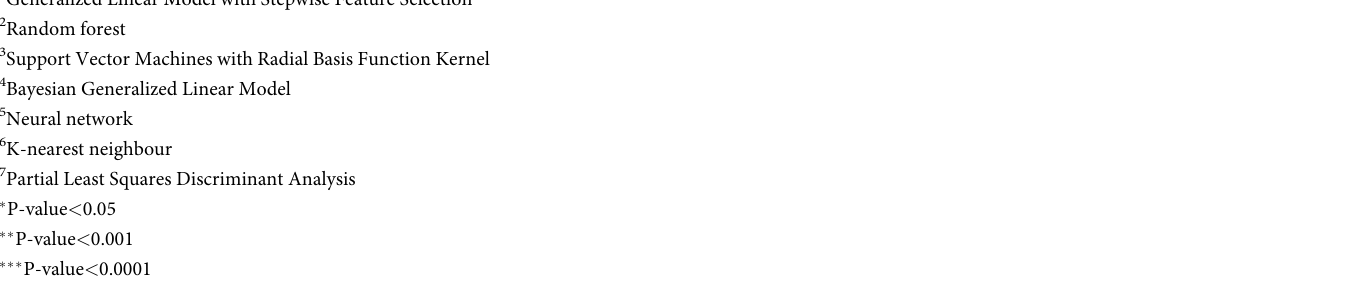
1 Generalized Linear Model with Stepwise Feature Selection 2 Random forest 3 Support Vector Machines with Radial Basis Function